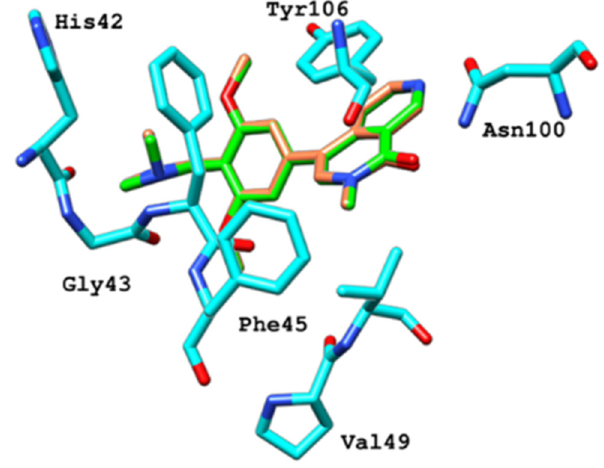
Figure 21. Re-docked conformation of a potent BRD9 inhibitor (BI-7273) inside the active site of BRD9 (PDB ID: 5EU1): crystallographic pose and re-dock pose (orange) using MOE 2018 [22].